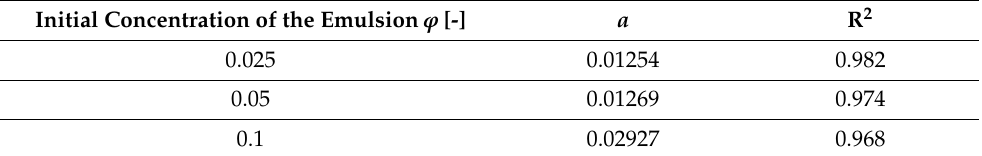
Table 1. Summary of parameter a and the coefficient of determination. Initial Concentration of the Emulsion ϕ